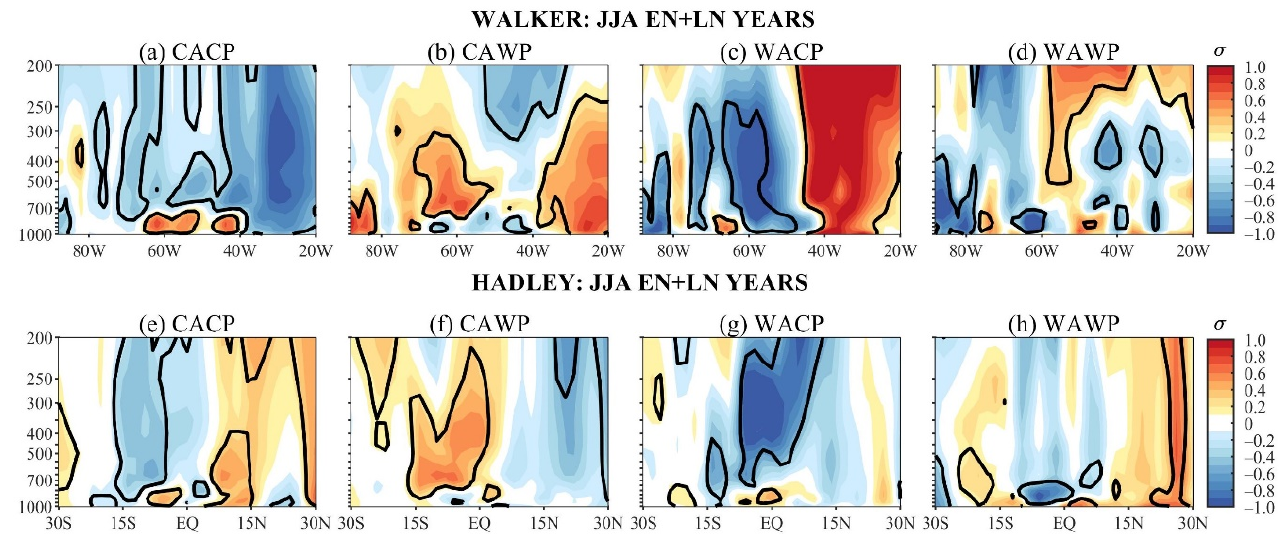
Figure 4. Austral winter longitude vertical cross-section of the WVEL anomaly composites of EN + LN during the: ( a ) CACP, ( b ) CAWP, ( c ) WACP, and ( d ) WAWP mean states; and latitude vertical cross-section of the HVEL anomaly composites of EN + LN during the: ( e ) CACP, ( f ) CAWP, ( g ) WACP, and ( h ) WAWP mean states. Continuous contours encompass the significant anomalies at a 90% confidence level using the Student’s t -test. The symbol σ above the colour bar means standard deviation.